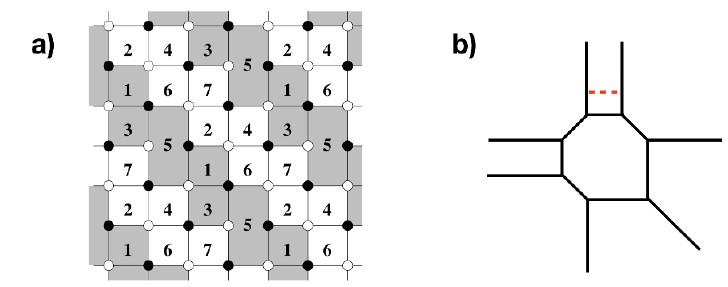
Figure 2 . (a) Dimer diagram showing an N = 2 fractional brane in the PdP 4 theory; (b) Web diagram, displaying the corresponding mobile P 1 as a red discontinuous